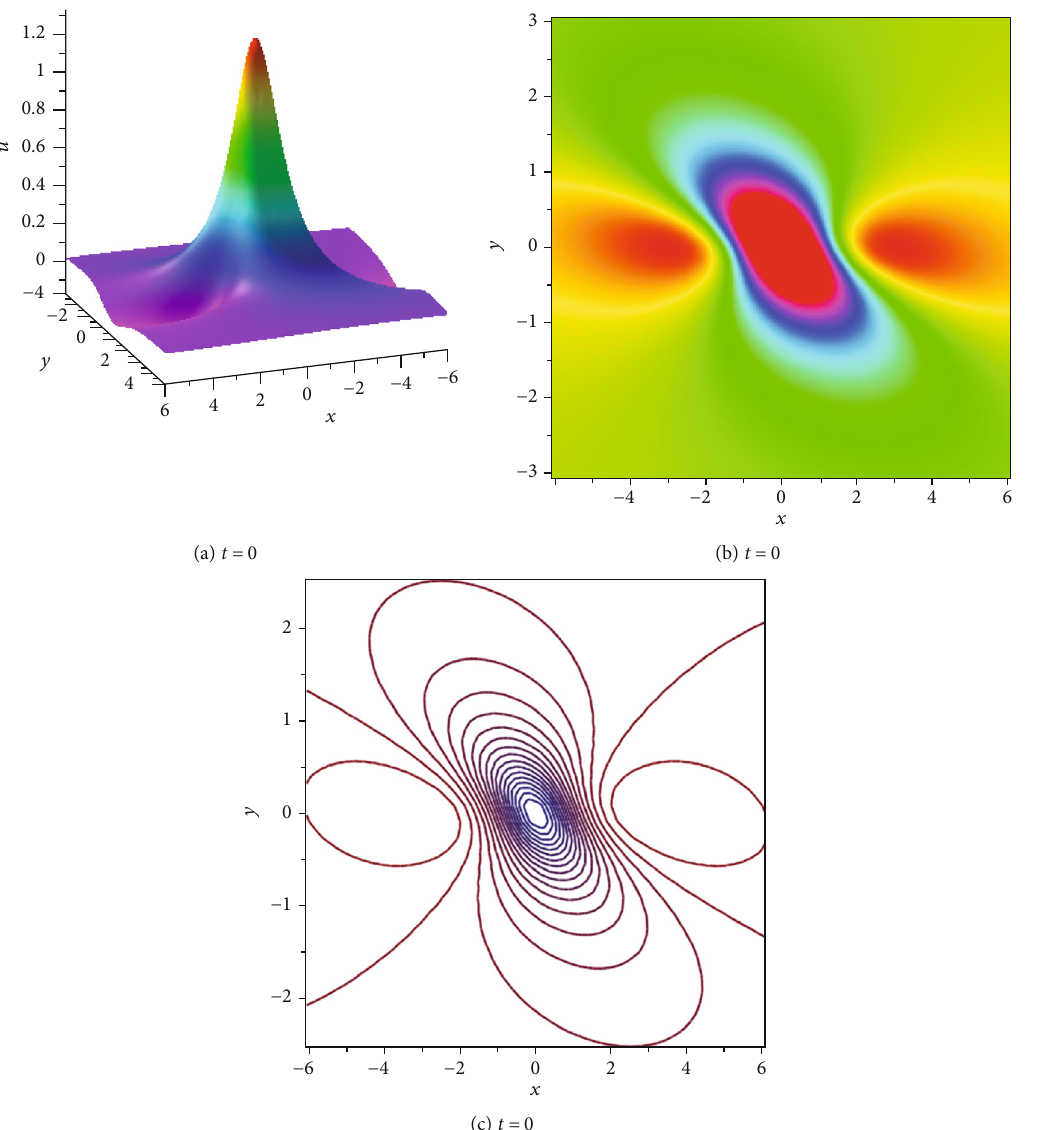
Figure 2: (Color online) The lump solutions v to Equation (6) at α = 3 . (b) Density plot of lump solution v . (c) Contour plot of lump solution v